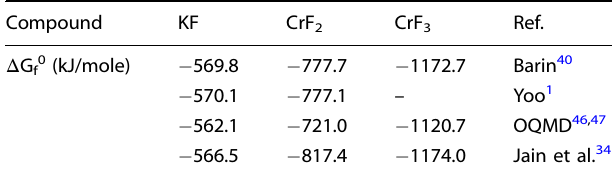
Table 4. Standard Gibbs free energy of formation ( Δ G o fl uoride and chromium- fl uoride compounds at T = 0 Kelvin obtained from various thermodynamic